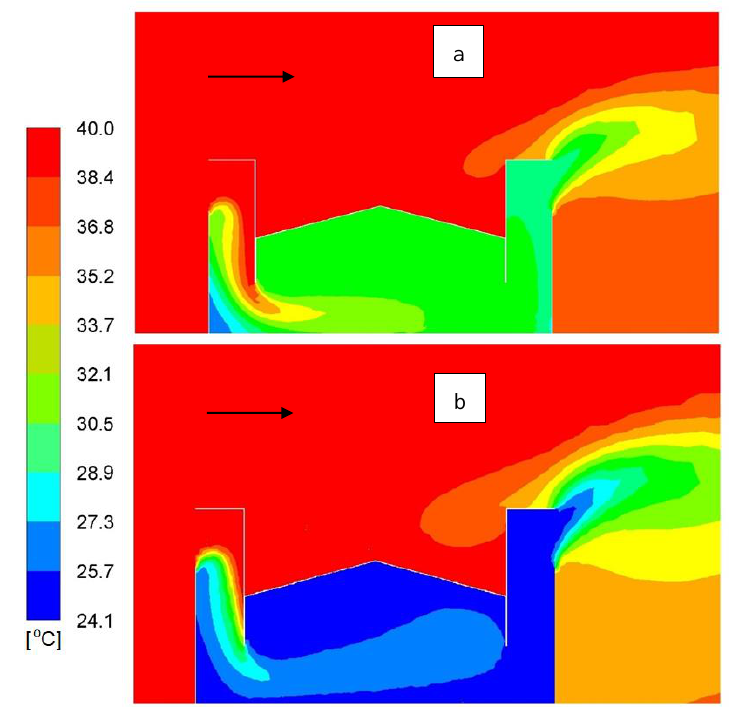
Figure 17. ( a ) Temperature contours at the midplane of the greenhouse using a windcatcher system with four parallel spray nozzles. ( b ) Temperature contour at the midplane of the greenhouse using a windcatcher system with eight parallel spray nozzles (ambient T = 40 °C, RH = 24.5%, U HWC = 4.4 m/s).